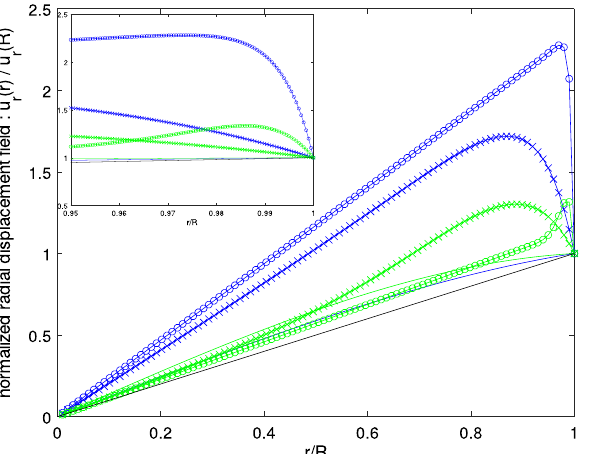
Figure 2. Normalized displacement field u r ( r )/ u r ( R ) as a function of the distance from the sphere’s center r for the chosen materials and R = (cid:31) (solid line), R = 10 × (cid:31) (crosses), R = 100 × (cid:31) (circles). The normalized displacement field for a membrane-based approach is reported in black. Inset: Zoom at the sphere’s surface.